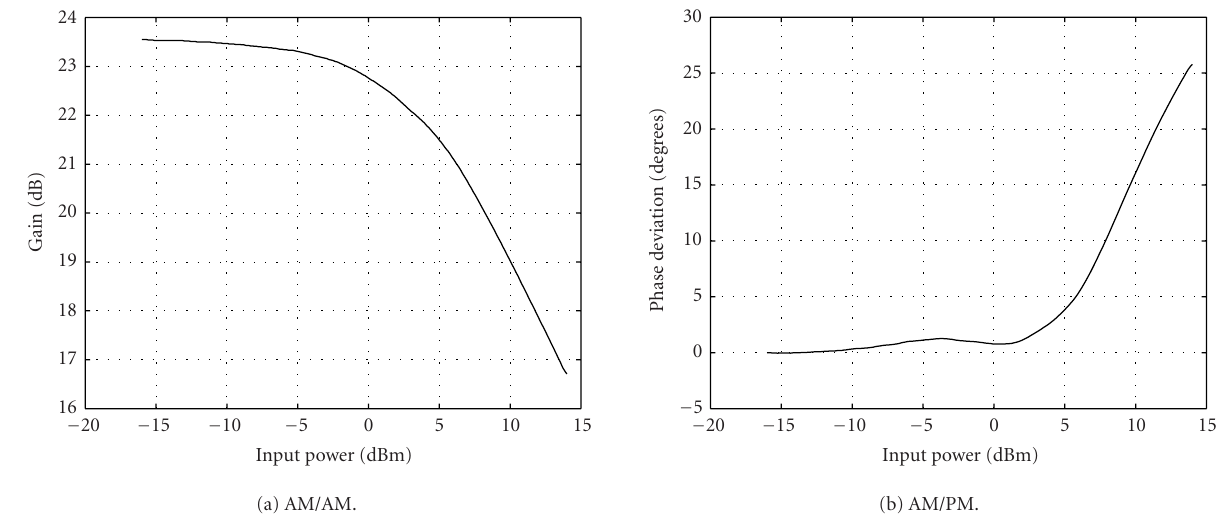
Figure 2: Measured AM/AM and AM/PM characteristics of a Class AB PA. Table 1: Estimated polynomial PA model coe ffi cients for three scenarios: (i) when both AM/AM and AM/PM conversions are present; (ii) when only the AM/AM conversion is present ( Φ ( r ) = 0); and (iii) when only the AM/PM conversion is present ( A ( r ) = 11 . 75 was used).